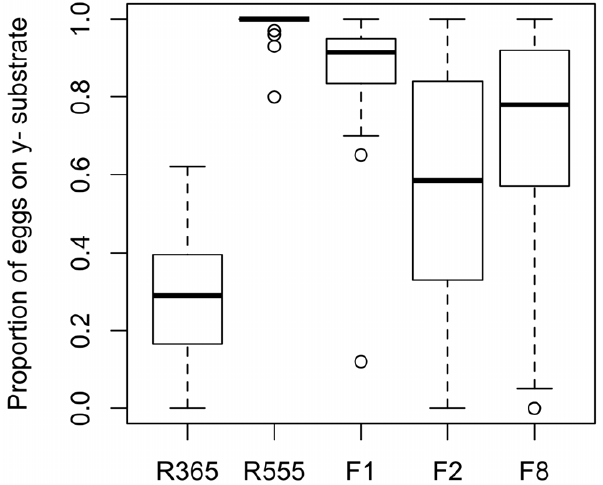
Figure 2. The distribution of preferences among females of two RAL genotypes (R555 and R365), their F1 offspring (with R555 as the maternal parent), and their F2 offspring. Median (line), 75% quartile (box), and range excluding outliers (whiskers), and outliers (circles) are shown.